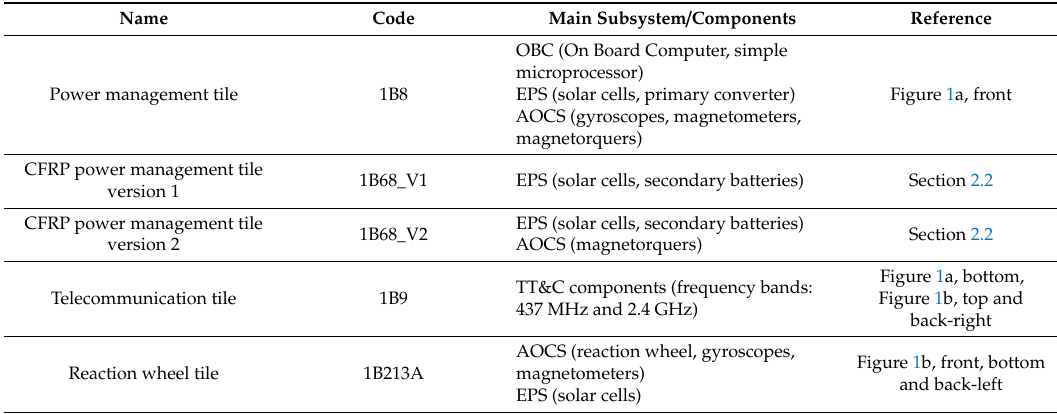
Table 1. Existing smart tiles.